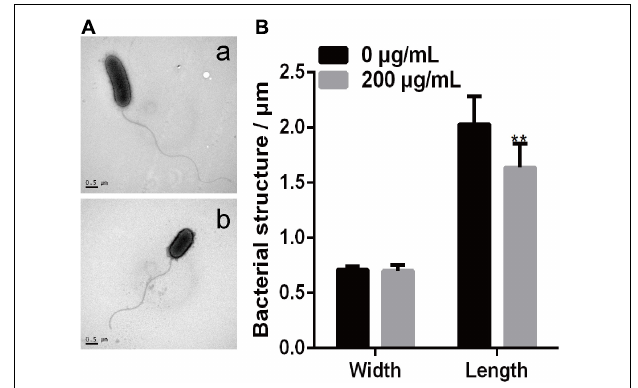
FIGURE 5 | Observations of Xoo morphology following treatment with melatonin. (A) The morphology of PXO99 cells. (a) The morphology of PXO99 cells not treated with melatonin. (b) The morphology of PXO99 cells treated with melatonin (200 µ g/mL). (B) Statistical analysis of the width and length of PXO99 cells. Bar = 0.5 µ